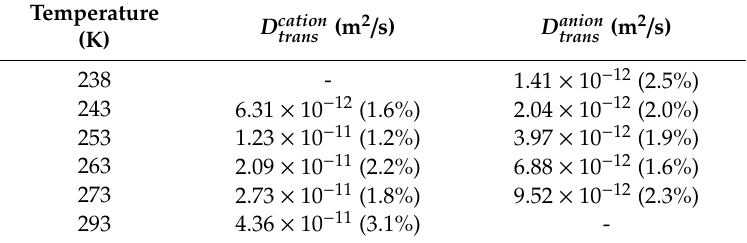
denotes the translation di ff usion coe ffi cient of the FSI anions. trans